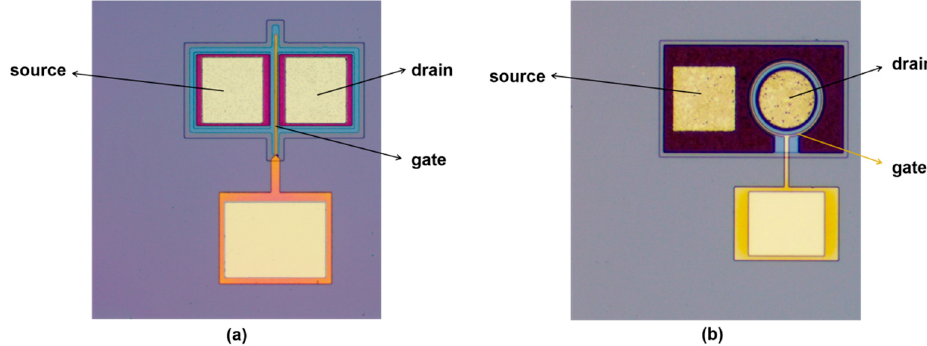
Figure 3. Optical microscope image of ( a ) conventional structure HEMT device ( b ) ring-gate HEMT device.